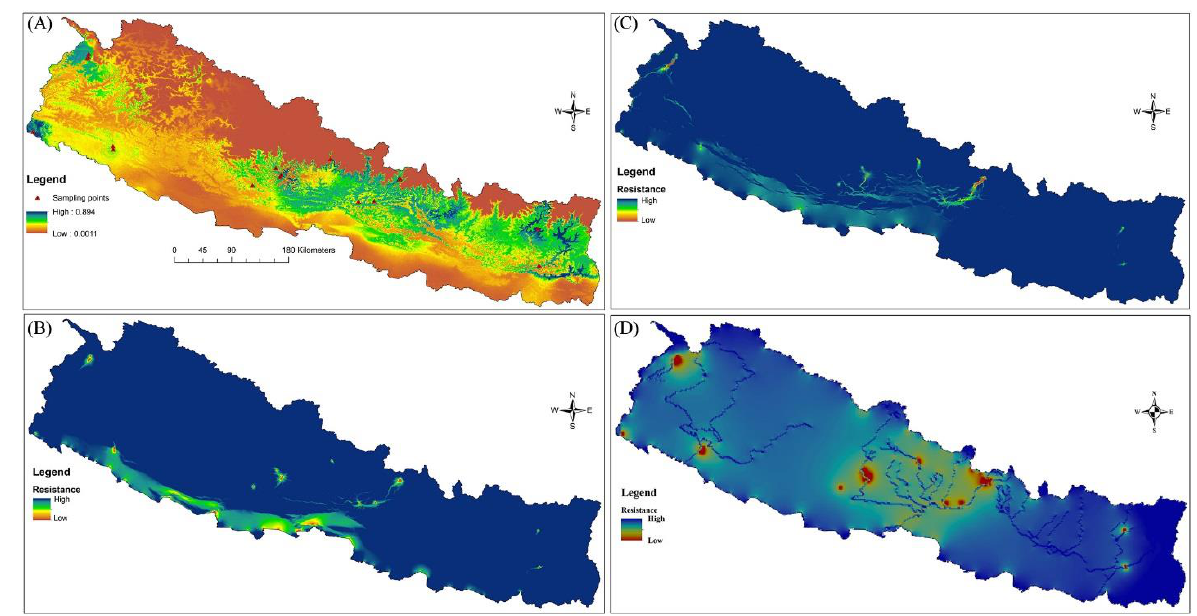
Figure 5. Test of isolation by resistance (IBR) for Himalayan langurs in Nepal. ( A ) Species distribution model showing a suitable habitat for Himalayan langurs. ( B ) Resistance grid output for the resistance surface of a suitable habitat. ( C ) Resistance grid output for the resistance surface of elevation. ( D ) Resistance grid output for the resistance surface of rivers.